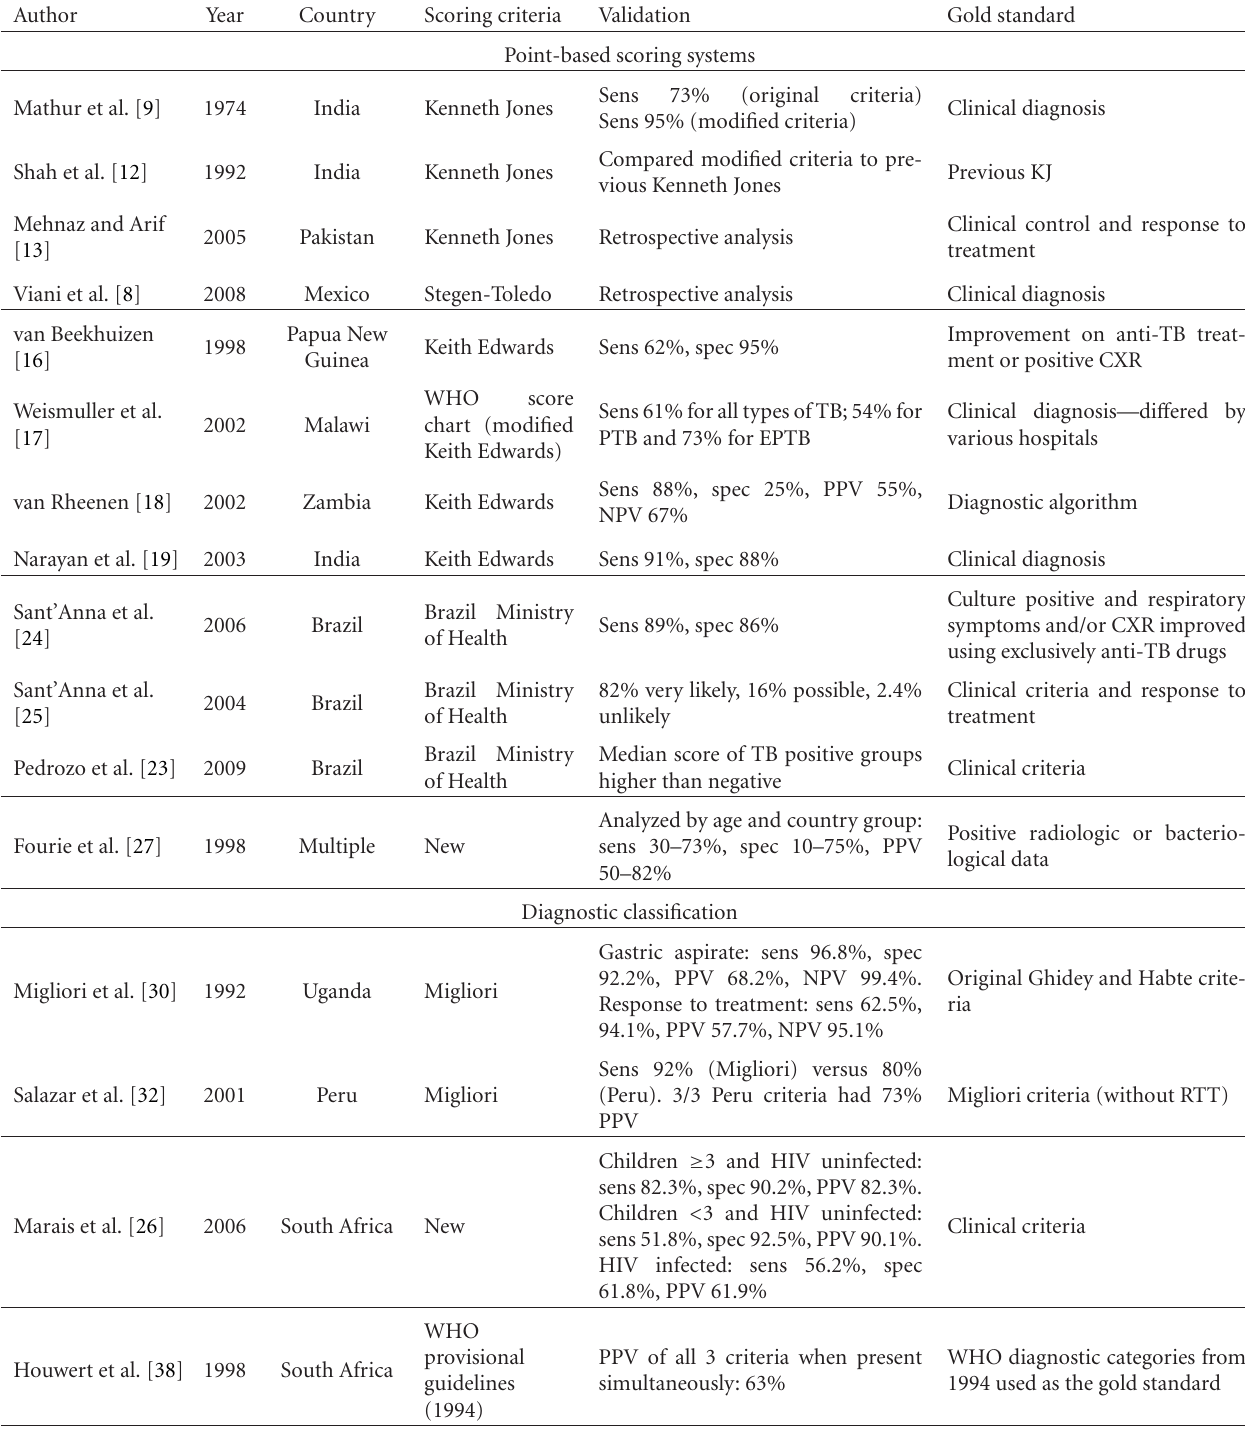
Table 4: Studies attempting validation of diagnostic